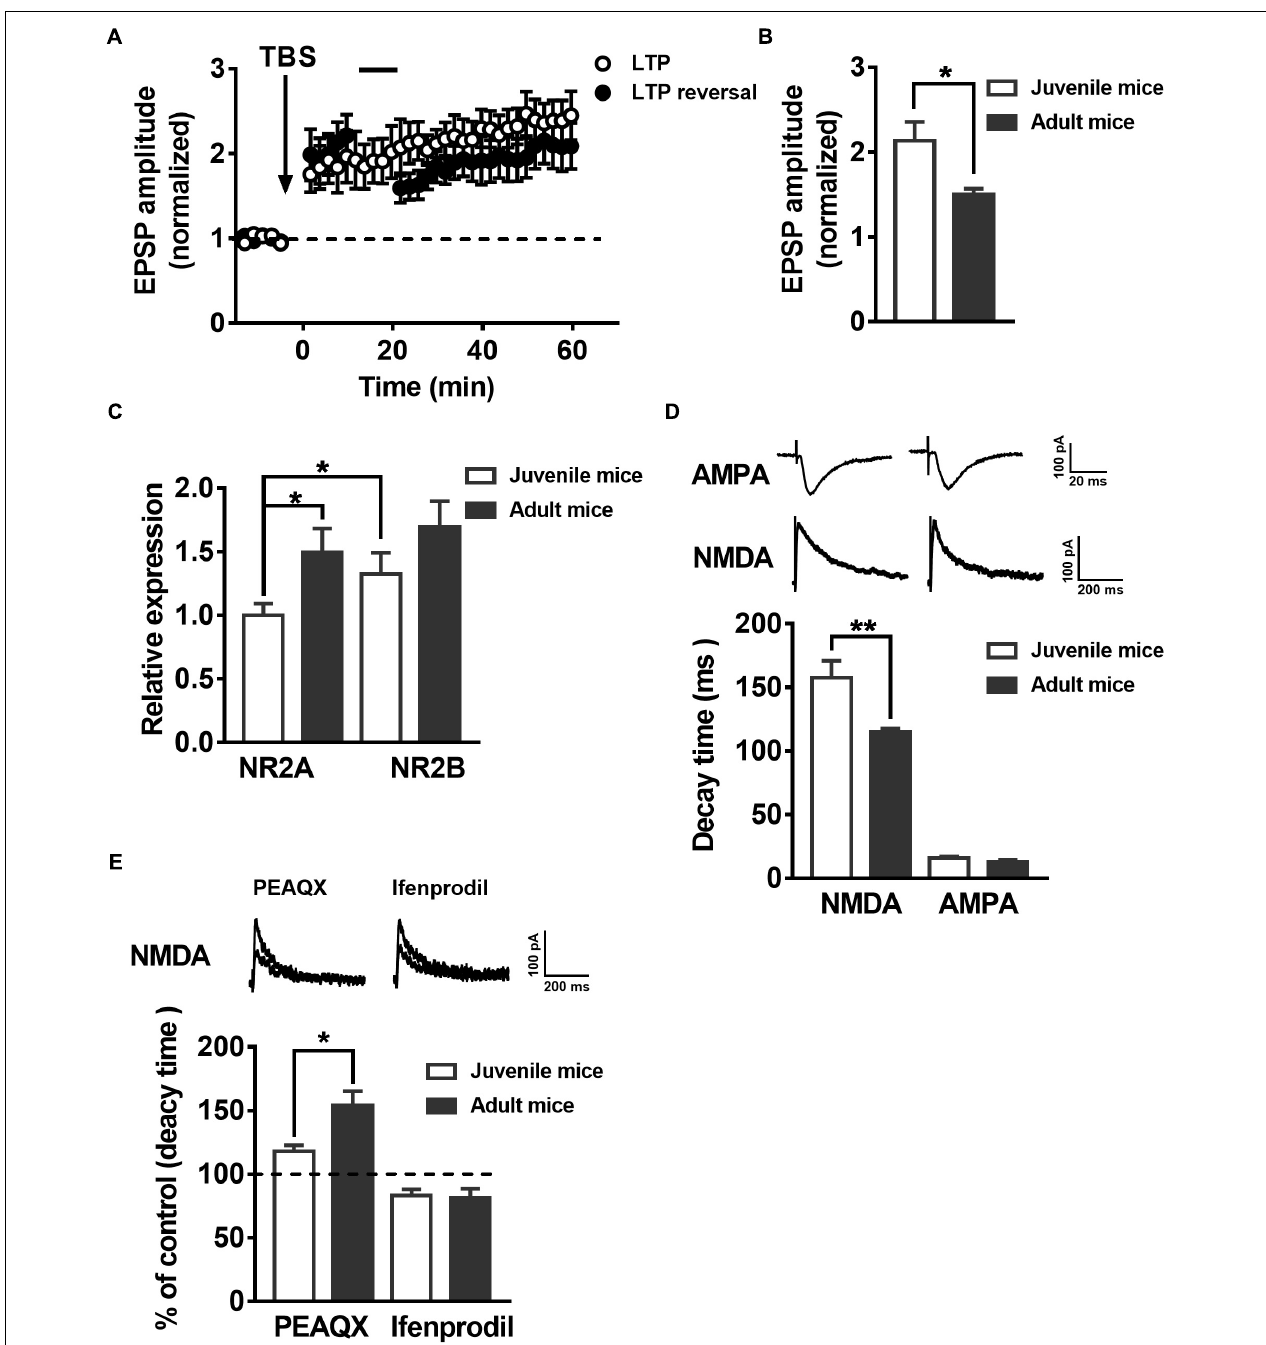
FIGURE 4 | LTP reversal and the expression of NMDAR subunits in the DG change with postnatal individual development. (A) LTP (open circles, n = 7 cells) and LTP reversal (solid circles, n = 7 cells) in juvenile mouse DGCs. (B) Summary of the mean LTP amplitude during LTP recording (0–60 min) in juvenile mouse mature DGCs and adult mouse mature DGCs. Values represent the mean ± SEM ( ∗ p < 0.05; unpaired t -test). (C) mRNA expression of the NMDAR subunits NR2AR and NR2BR in the DG of juvenile and adult mice. The relative expression of DG NR2A mRNA in adult mice was significantly higher than in juvenile mice. Values represent the mean ± SEM ( ∗ p < 0.05; t -test). (D) Shown in the top row are typical example traces of AMPA- and NMDA-EPSCs recorded under whole-cell voltage-clamp. Bottom row, the statistical analysis demonstrates that the decay time of NMDA-EPSCs is slower in juvenile (white bar) than in adult (black bar) mouse mature DGCs, whereas the decay time of AMPA-EPSCs did not have an obvious change during individual development. Values represent the mean ± SEM ( ∗∗ p < 0.01; unpaired t -test). (E) Shown in the top row are typical sample traces of NMDA-EPSCs before and after perfusing the PEAQX or ifenprodil in adult mouse mature DGCs. The bottom row shows the quantification of decay time of NMDA-EPSCs in juvenile (white bar) and adult (black bar) mouse mature DGCs after PEAQX and ifenprodil perfusion. Values represent the mean ± SEM ( ∗ p < 0.05; unpaired t -test).